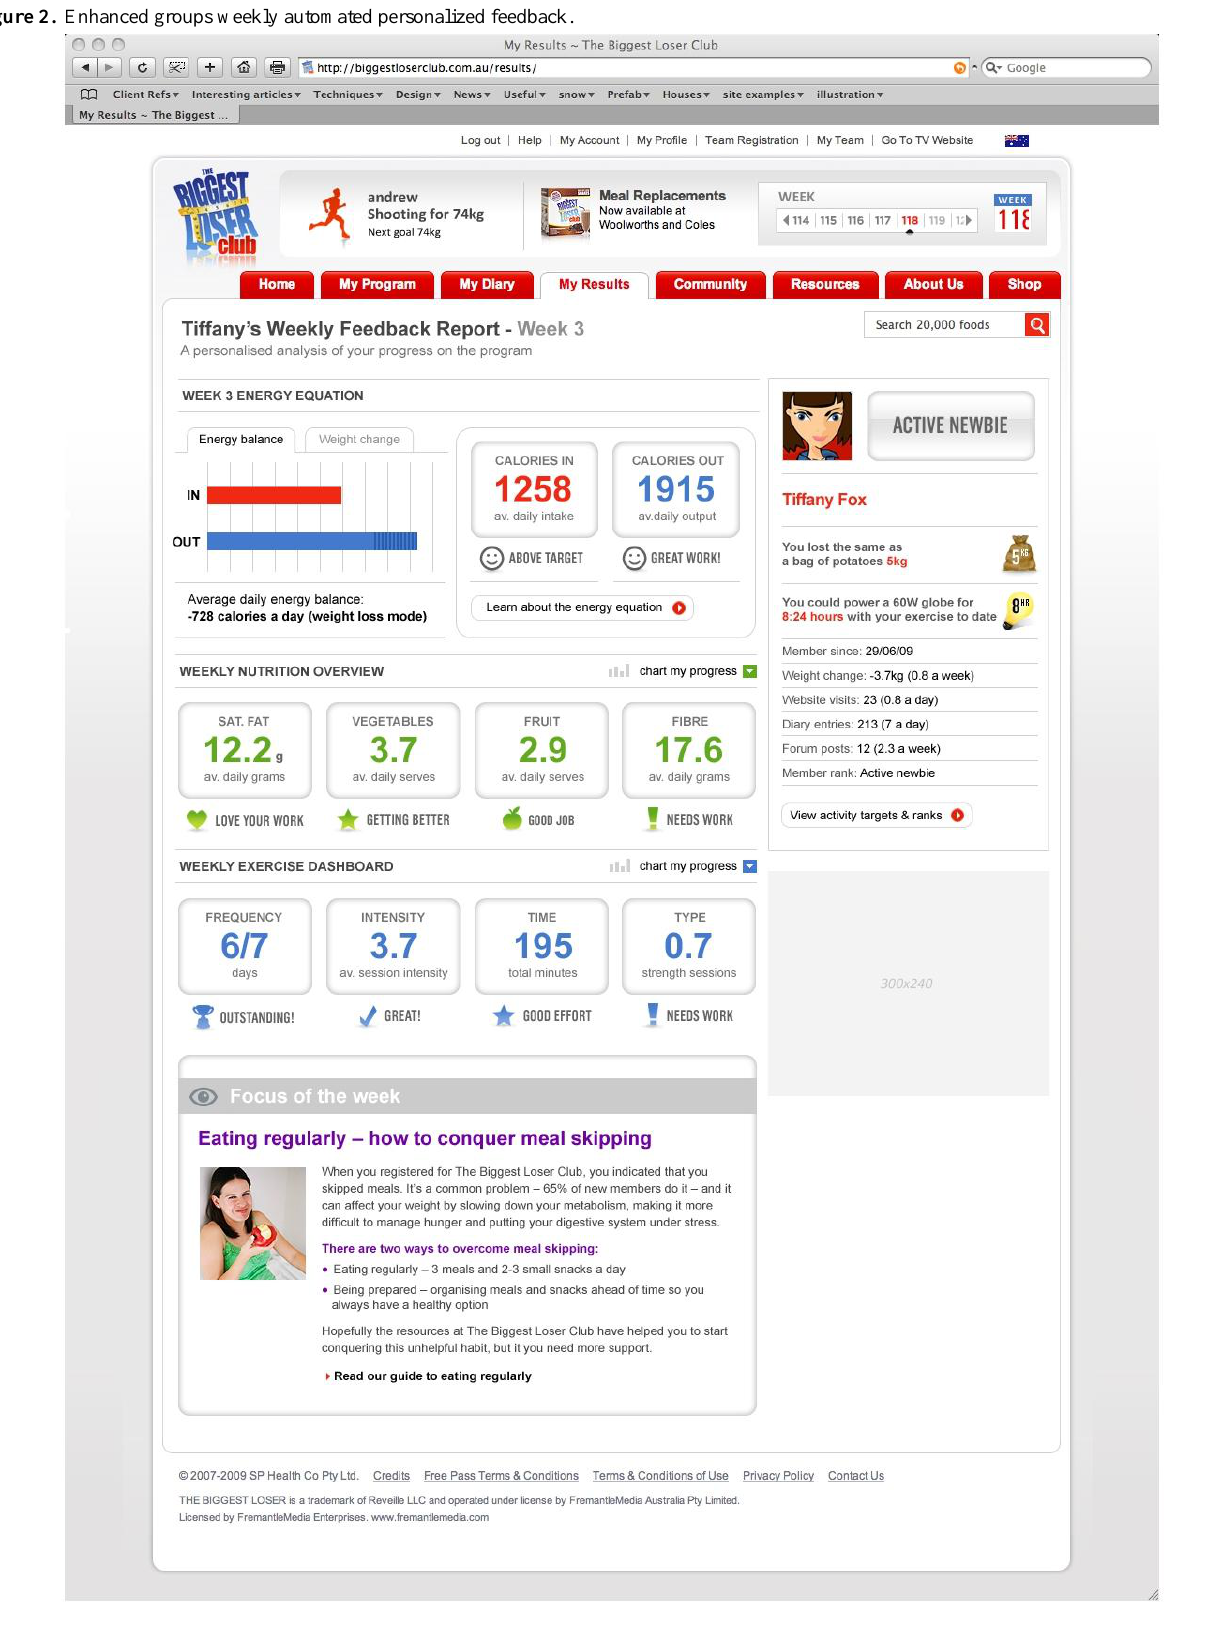
Figure 2. Enhanced groups weekly automated personalized